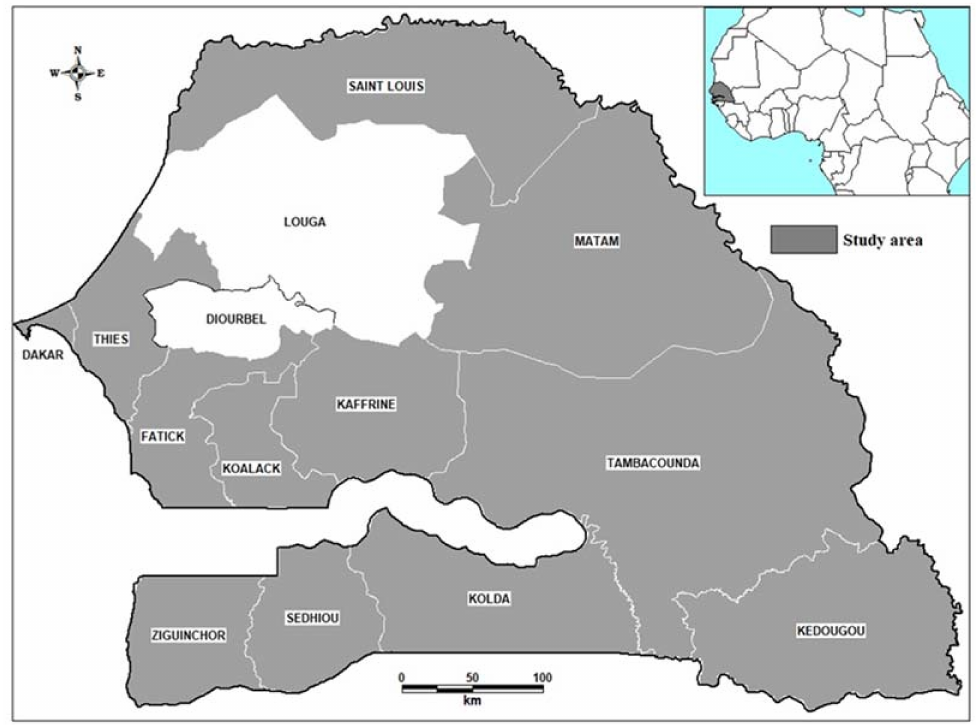
Figure 1. Location of the study zone (source: from